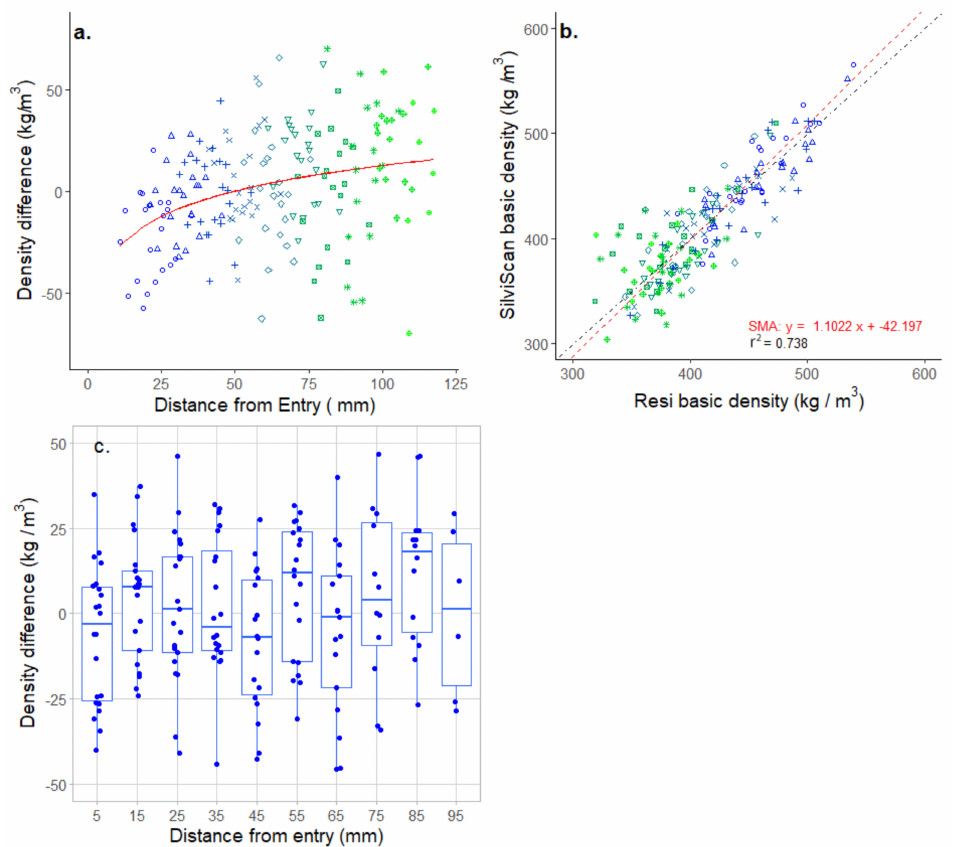
Figure 9. ( a ) The differences between segment and SilviScan density values plotted as distance from the entry into the bark. ( b ) Mean corrected Resi-predicted density of 10 mm segments compared to the SilviScan density values. ( c ) The logarithmic correction removed the under-prediction of the first